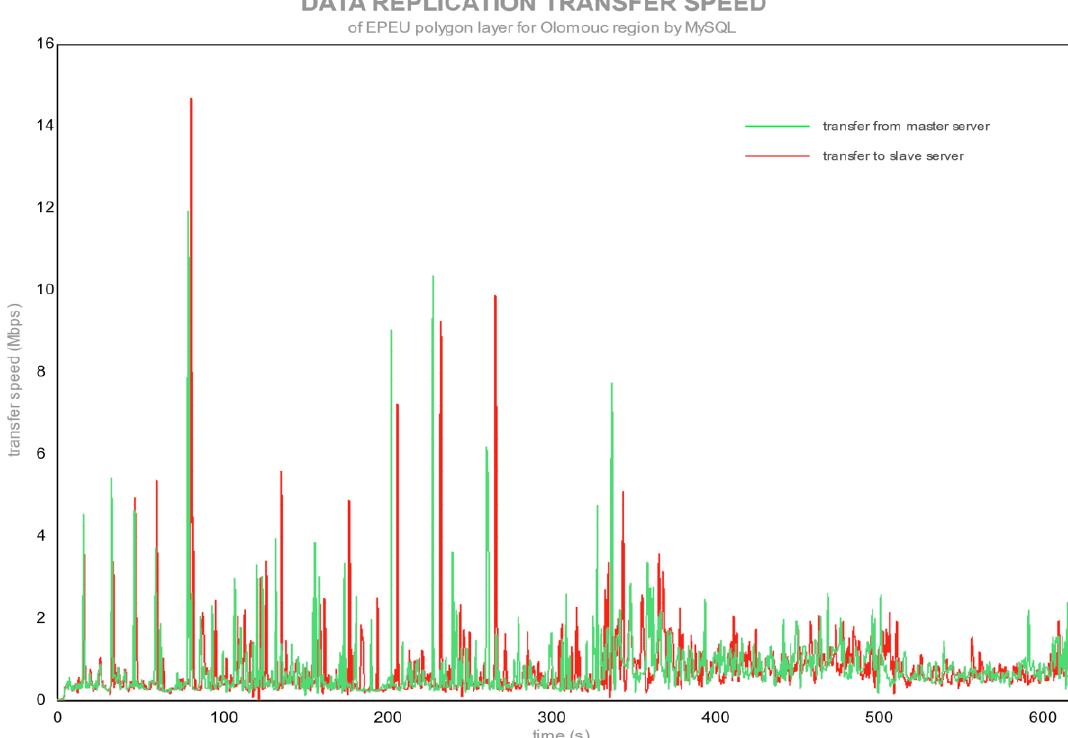
Figure 6. Replication transfer speed of the EPEU layer by MySQL.